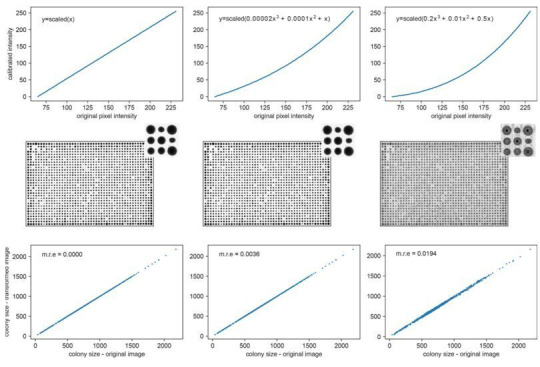
Pixel calibration is not required for accurate determination of colony sizes.Top row: calibration functions applied to the original scanned image. The first function is a linear transformation that scales the image to fill the entire 8bit range. We apply this to images in batch (but not timecourse) analysis by default. The other functions are 3rd-degree polynomials (as used by scan-o-matics). Middle row: Transformed images with upper right corner magnified. The third function has strong non-linear components which result in visible distortion of the image. Bottom row: colony sizes obtained with pyphe-quantify batch of the transformed images versus the original image. The median of the relative error abs(size(transformed)-size(original))/size(original) across the plate is noted. This is negligibly small when compared to the variation of colony sizes.